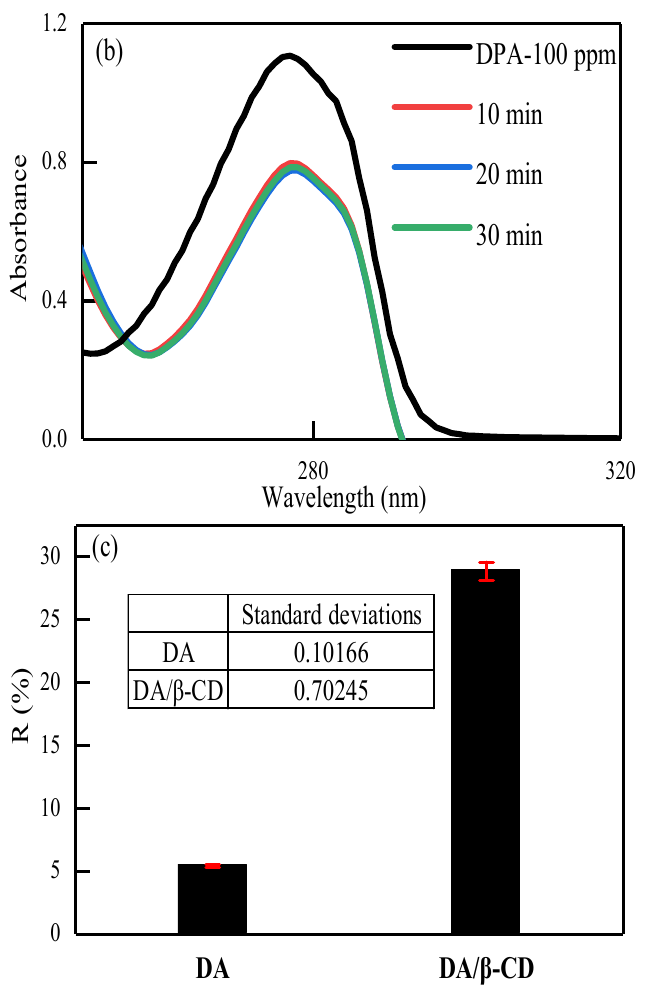
Figure 6. ( a ) UV-vis absorption spectrum of DPA after adsorbed by DA and DA/ β -CD ( b , c ) adsorp- tion rates of DPA. 0.2 g adsorbent in 50 mL of DPA solution (100 ppm) at room temperature. tion rates of DPA. 0.2 g adsorbent in 50 mL of DPA solution (100 ppm) at room